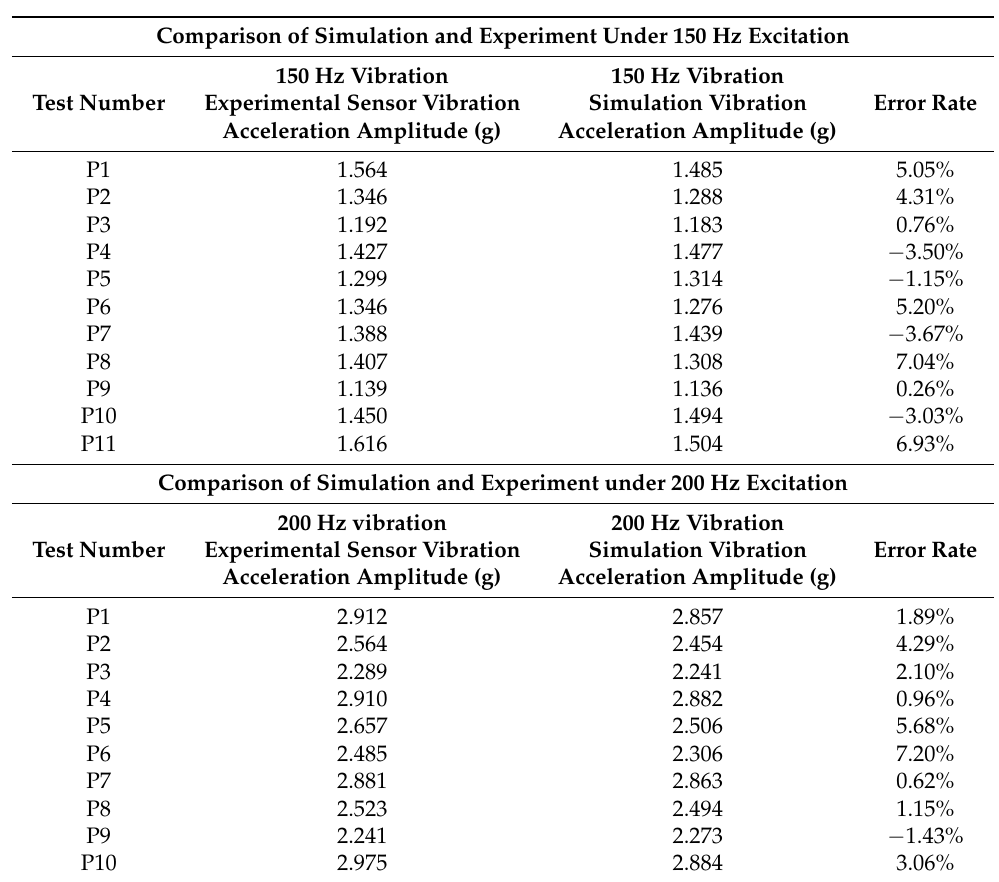
Table 12. Simulation and experimental data comparison of the aeronautical hydraulic clamp-pipeline system under fixed-frequency excitation before and after hard